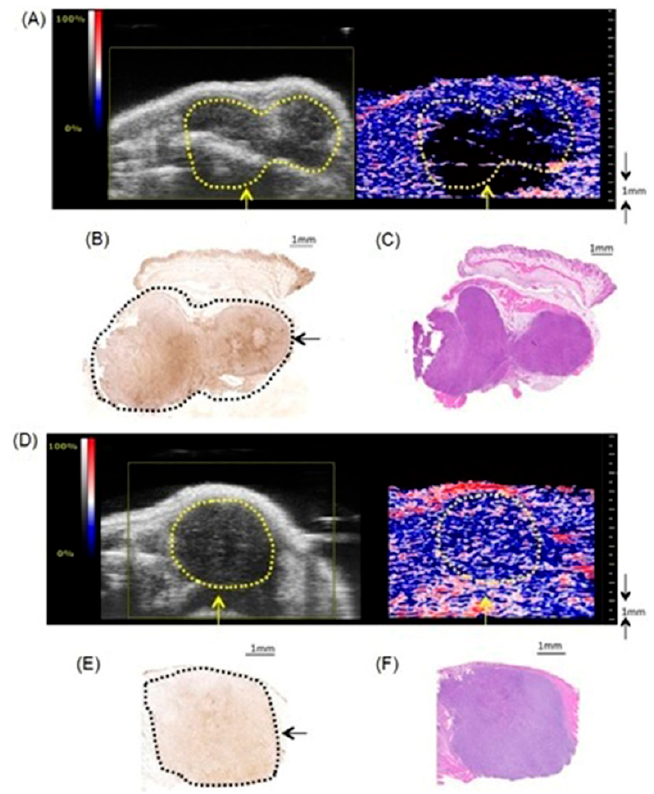
Figure 3. Imaging of tumor hypoxia in subcutaneous pancreatic xenografts. ( A ) Representative oxy-hemo photoacoustic image of a hypoxic tumor. B-mode image (left panel) and oxygen saturation map (oxy-hemo photoacoustic imaging, right panel). The heat map represents oxygen saturation level, ranging from 100% (red) to 0% (dark blue). The yellow dashed line defines the tumor region. ( B ) Representative hypoxia staining (brown color) of the same tumor. The black dashed line defines the tumor region. ( C ) Representative hematoxylin and eosin staining of the same hypoxic tumor. ( D ) Representative oxy-hemo photoacoustic image of a non-hypoxic tumor. B-mode image (left panel) and oxygen saturation map oxy-hemo photoacoustic image (right panel). The heat map represents oxygen saturation level, ranging from 100% (red) to 0% (dark blue). The yellow dashed line defines the tumor region. ( E ) Representative pimonidazole staining of the non-hypoxic tumor, which lacks brown staining. The black line represents the tumor region. ( F ) Representative hematoxylin and eosin staining of the non-hypoxic tumor. Adapted with permission from Gerling, M.; Zhao, Y.; Nania, S.; Norberg, K. J.; Verbeke, C. S.; Englert, B.; Kuiper, R. V.; Bergström, A.; Hassan, M.; Neesse, A.; Löhr, J. M.; Heuchel, R. L. Real-time assessment of tissue hypoxia in vivo with combined photoacoustics and high-frequency ultrasound. Theranostics , 2014 , 4 , 604